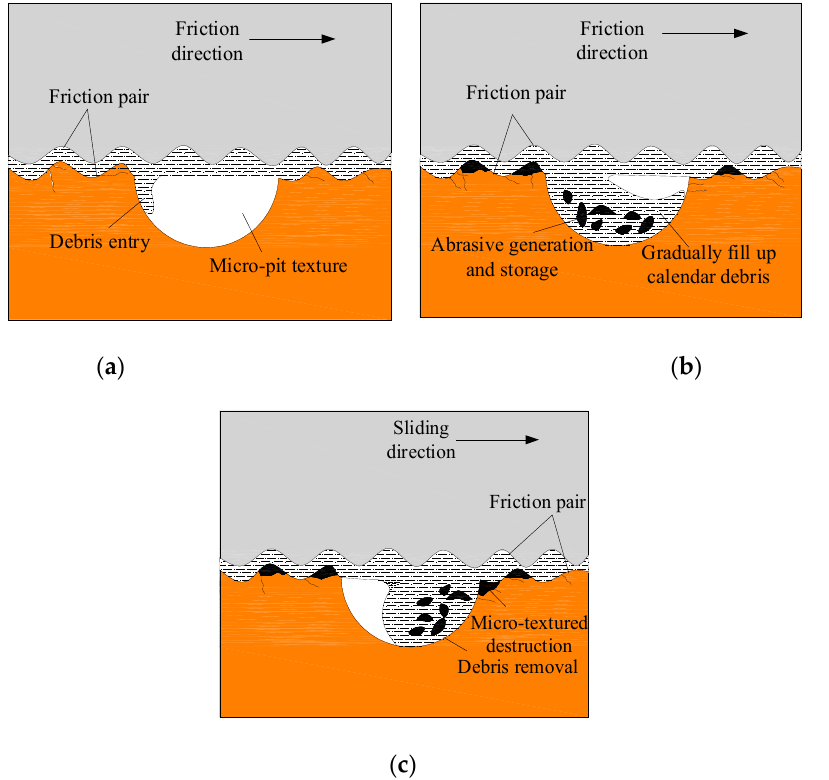
Figure 6. Wear mechanism analysis of micro-textured surfaces. ( a ) Friction and wear on micro-textured surface I. ( b ) Friction and wear on micro-textured surface II. ( c ) Friction and wear on micro-textured surface III.